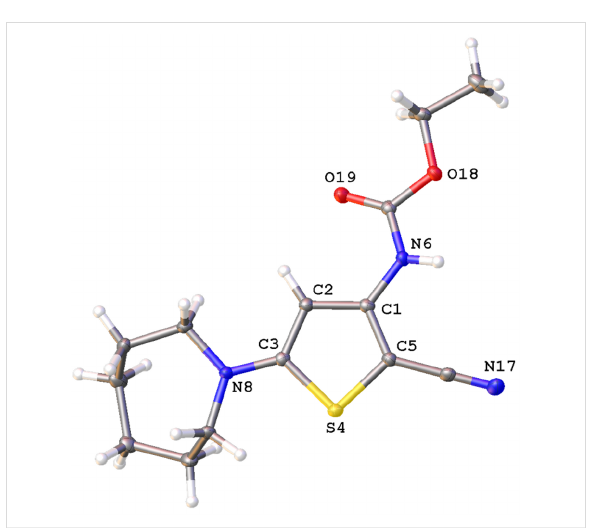
Figure 3: The structure of thiophene 5c according to the data of X-ray analysis (Olex2 plot with 50% probability level of ellipsoids).